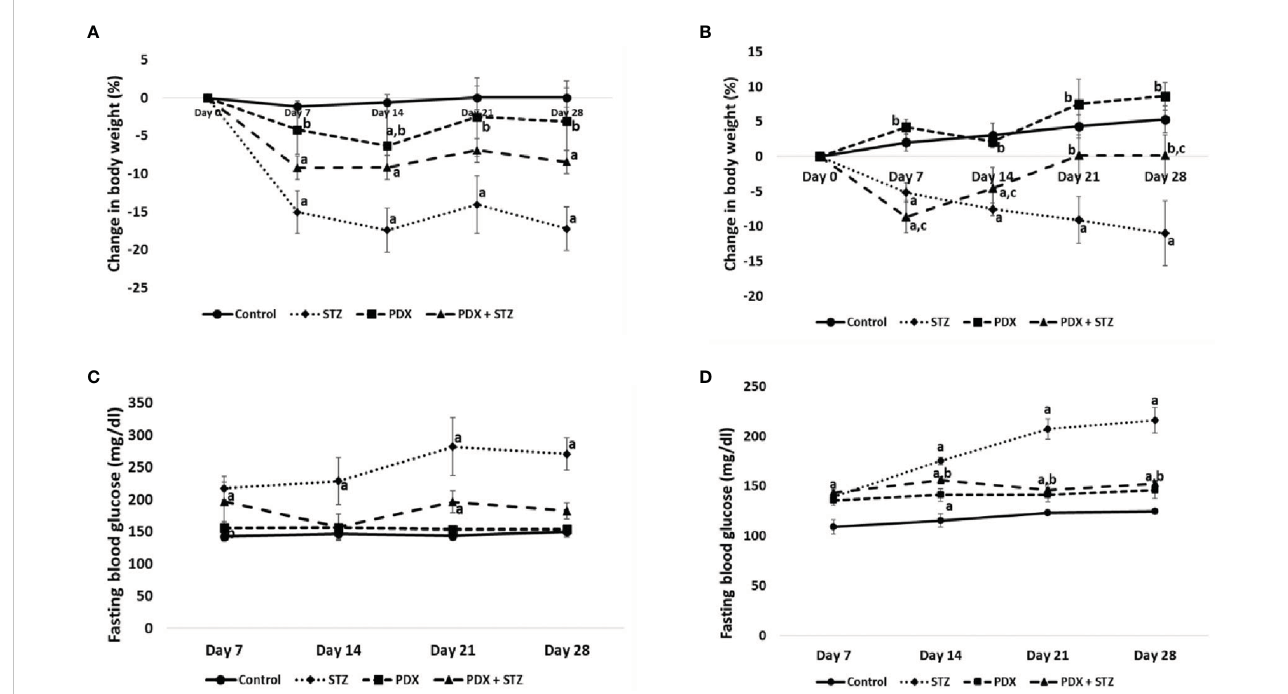
TABLE 2 Insulin sensitivity index (ISI) in STZ-induced Type 1 DM and Type 2 DM mice.